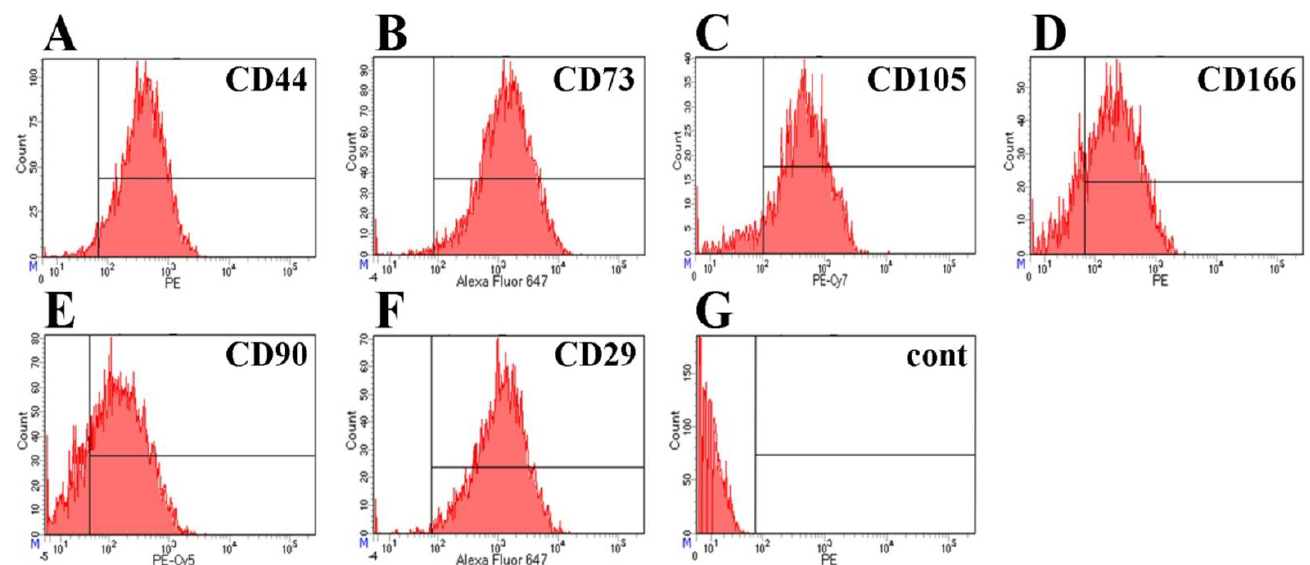
Figure 1. Immunocytofluorimetric characterization of surface antigens (CD markers) of BM-MSCs. ( A ) CD44 (95.9% of positive cells), ( B ) CD73 (98.2%), ( C ) CD105 (88.6%), ( D ) CD166 (79.6%), ( E ) CD90 (79.2%), ( F ) CD29 (98.5%), ( G ) negative control: CD34, CD11b, CD19, CD45, and HLA-DR (0% positive cells).